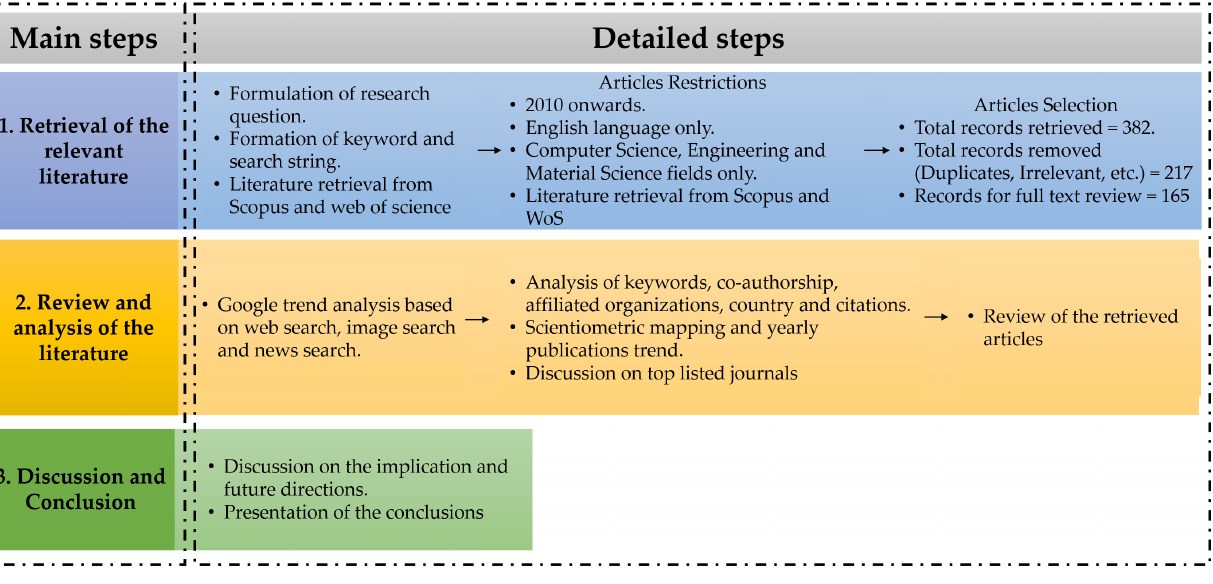
Figure 2. Methodology of the current